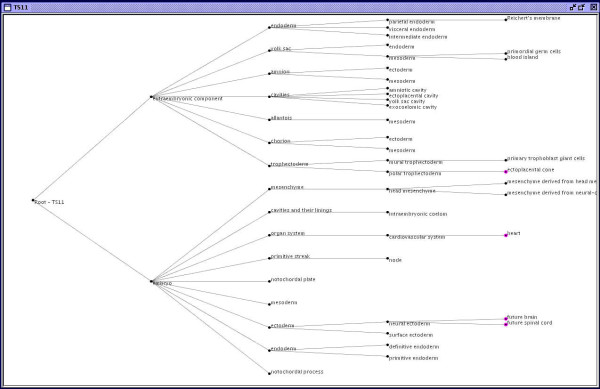
The L-R layout for the first five levels of TS11